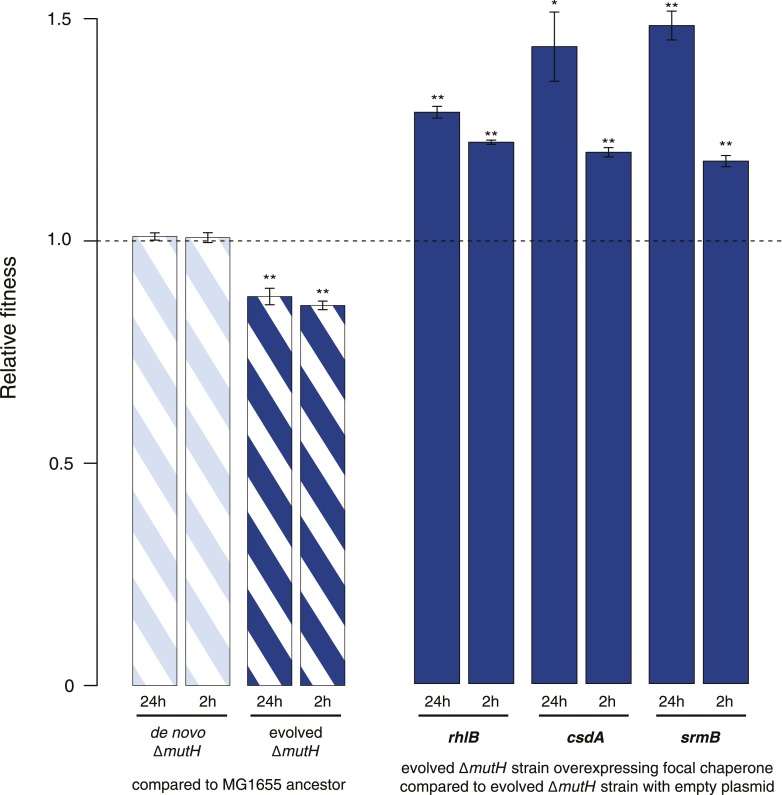
Relative fitness in competition experiments terminated in mid-exponential phase (MG1655).